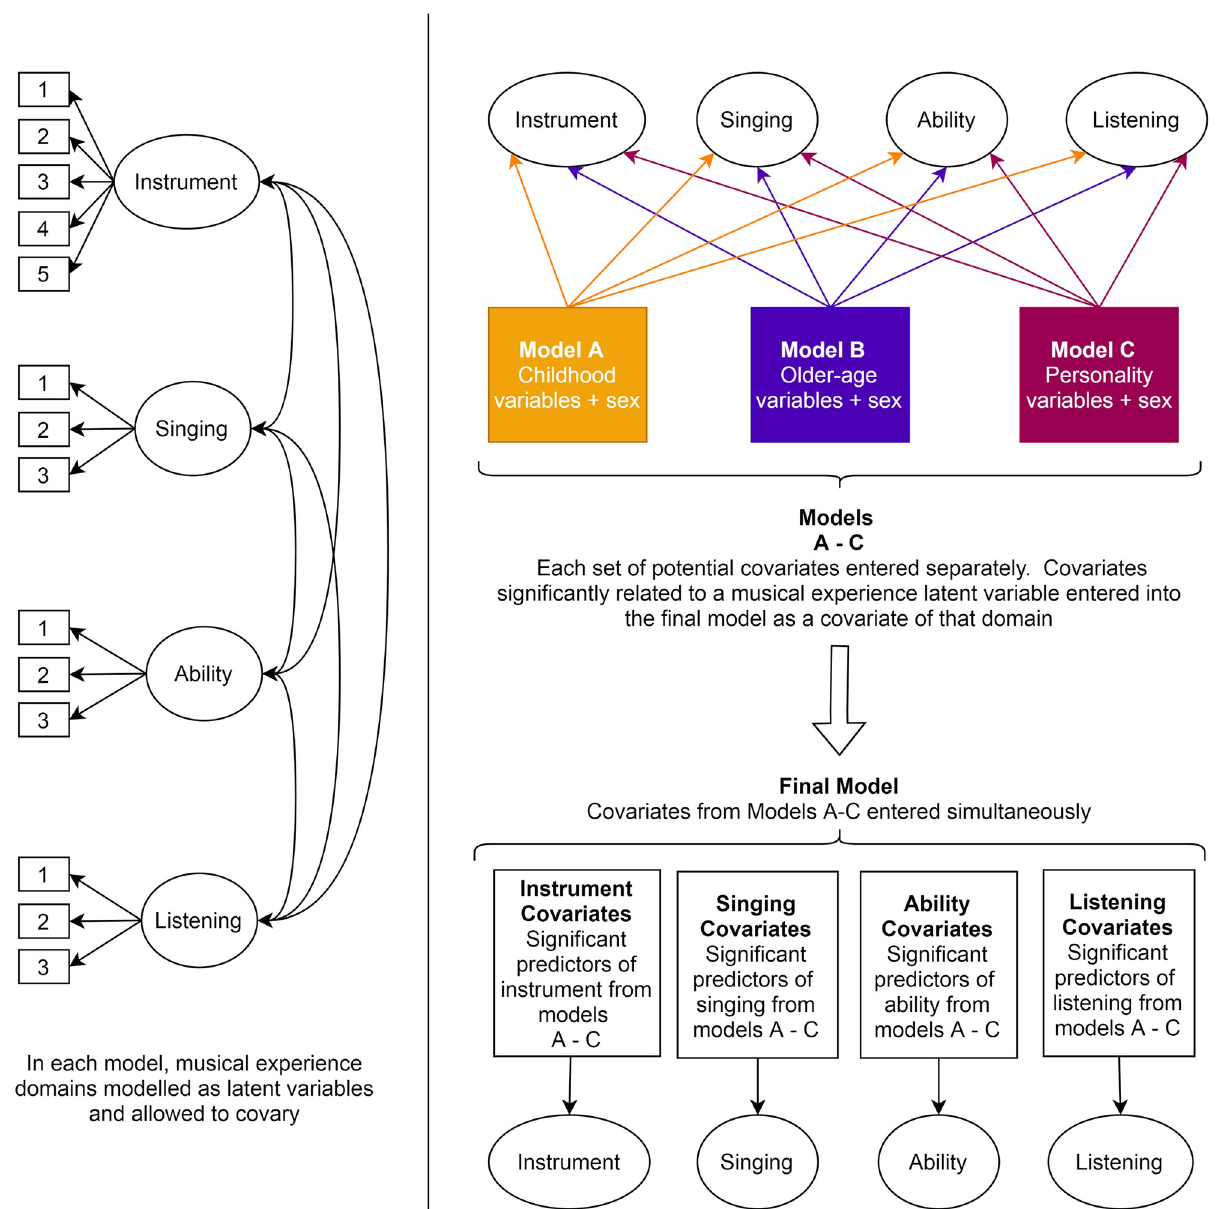
Fig 1. Illustration of the latent variables representing playing a musical instrument , singing , self-reported musical ability and music listening (left) and our approach to testing for associations between musical experience domains and non-musical variables (right). Ellipses represent latent variables, rectangles observed variables, single headed arrows regression paths or factor loadings and double headed arrows covariances.